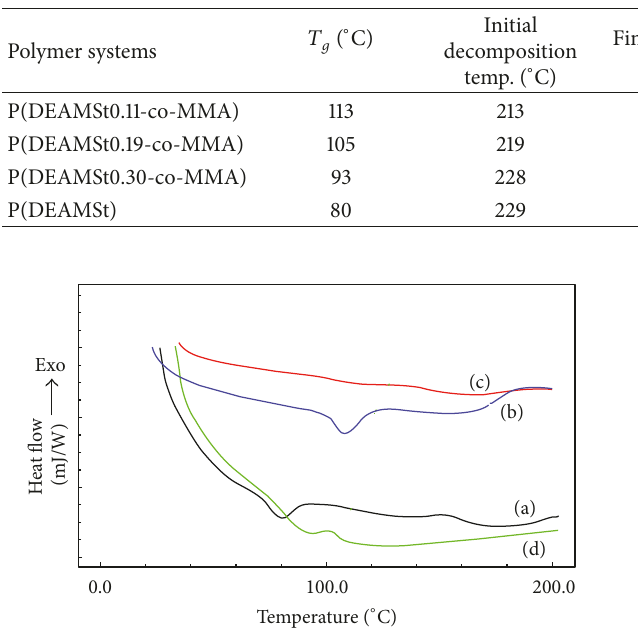
Figure 7: DSC curves of (a) P(DEAMSt), (b) P(DEAMSt0.11-co- MMA), (c) P(DEAMSt0.19-co-MMA), and (d) P(DEAMSt0.30-co- MMA).